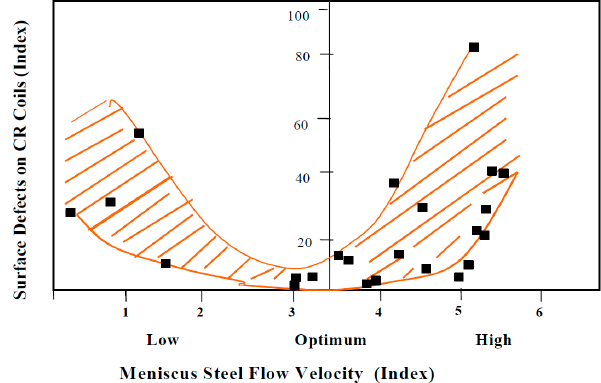
Figure 9. Slab/coil defects are minimum in an optimum window of steel meniscus velocities between weak and excessive double-roll flow conditions. NKK Corporation data; 700 to 1650 mm wide, 235-mm-thick slabs cast at 1.6 to 2.8 m/min [16].